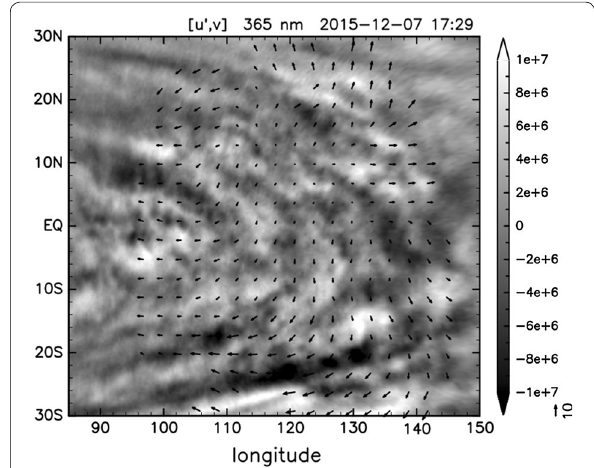
Fig. 10 Horizontal velocities derived from three 365‑nm images on the day of Akatsuki ’s Venus orbit insertion (7 December 2015). Arrows show their deviation from the uniform westward wind of 95 m/s. The length scale of the arrows is shown in m/s near the lower‑right corner. Grayscale shading shows the high‑passed radiance (W/m 2